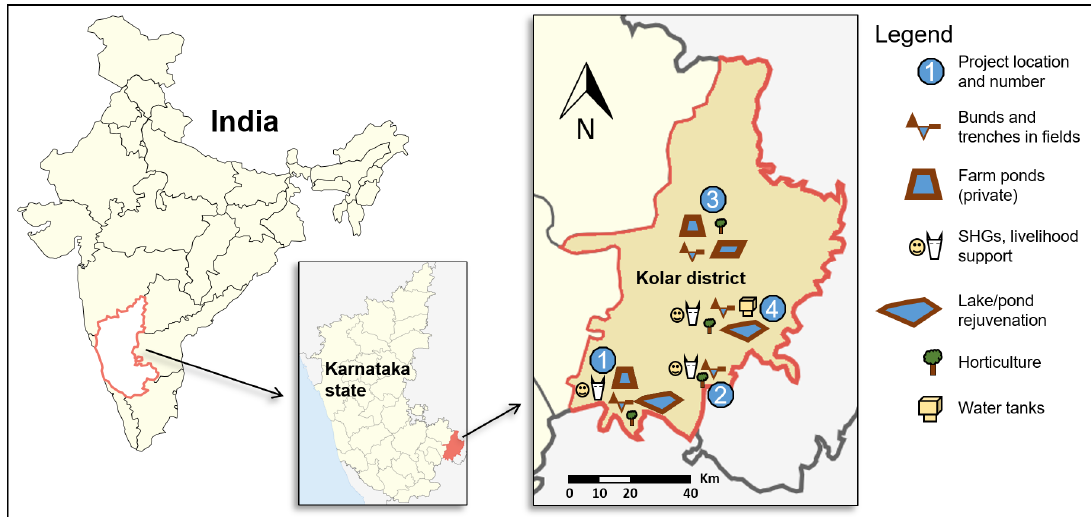
Figure 1. Map showing approximate locations of completed WSD projects included in this study and components of each project (modified from images by 3xK and PlaneMad , respectively, distributed under a CC-BY 2.0 license). SHG, self-help group